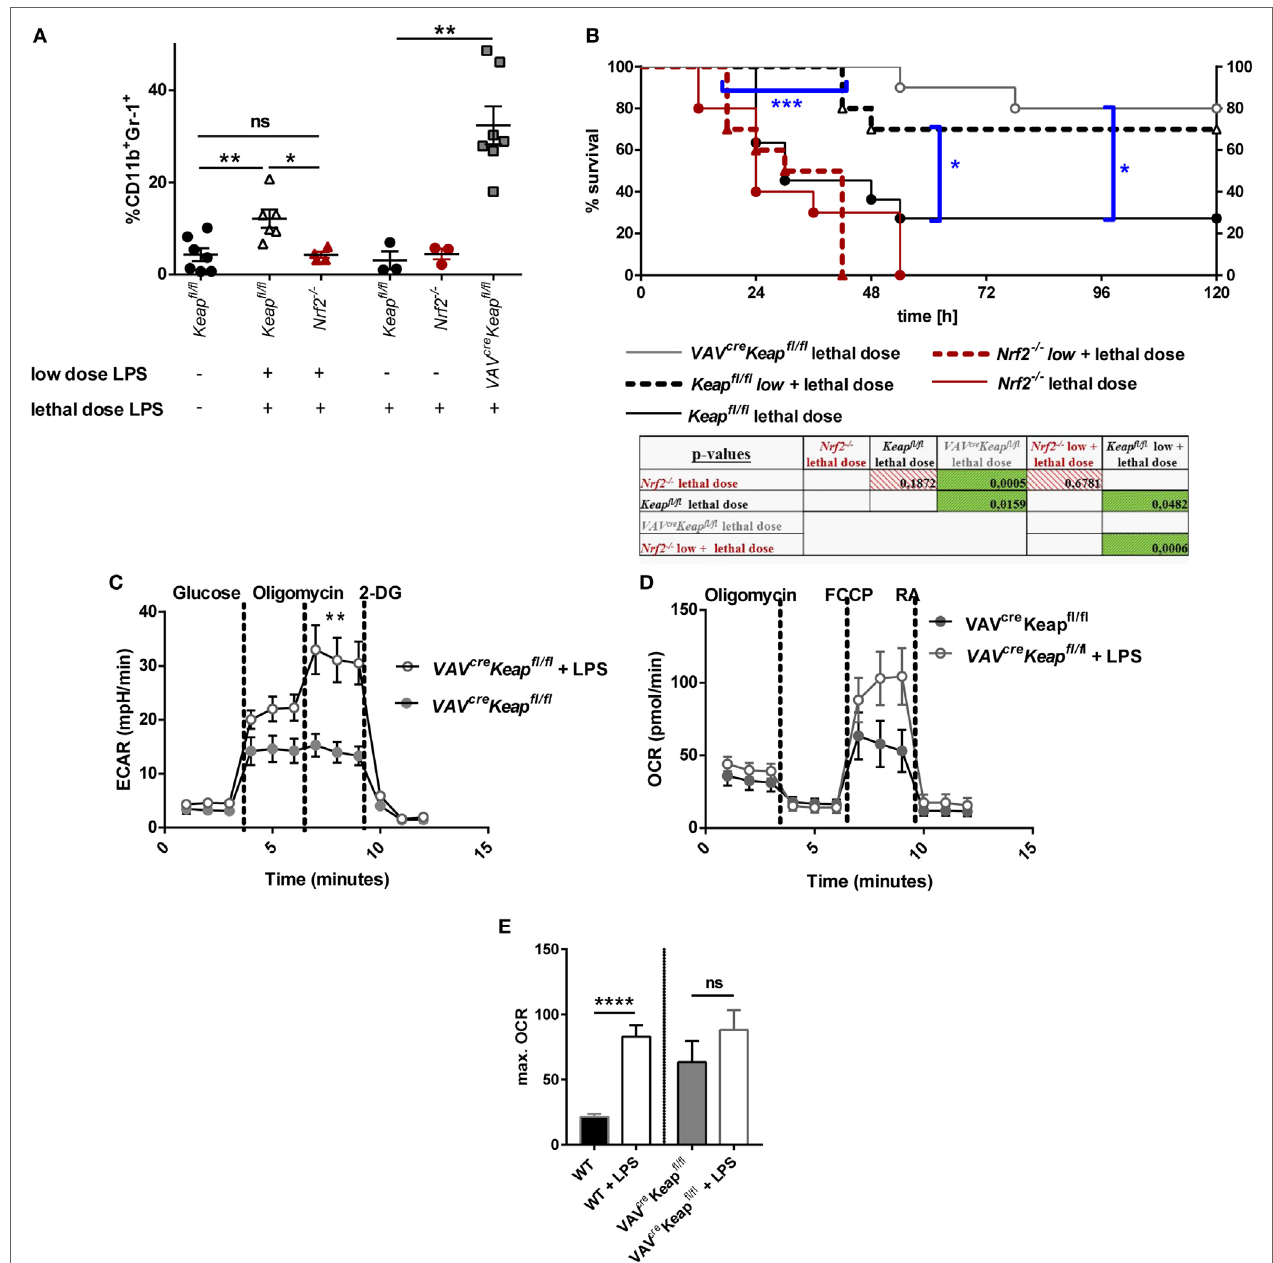
FigUre 7 | Nrf2 activation in myeloid-derived suppressor cells (MDSCs) regulates LPS-mediated disease. (a) Mice were injected with either a low dose of LPS (5 mg/kg of body weight) and subsequently with a lethal dose of LPS (30 mg/kg of body weight) or solely with a lethal dose of LPS (30 mg/kg of body weight). Mice were euthanized depending on a scoring system (usually within the first 48 h after the single lethal dose) or 72 h after injection of the subsequent lethal dose and frequencies of CD11b + Gr-1 + cells were determined, unpaired, two-tailed t -test, ± SEM, N = 10 mice/group. (B) Kaplan–Meyer survival curves of mice, p -values were determined by Log-rank/Mantel-Cox Test of survival curves (single comparisons) and a subsequent FDR correction of single p -value for multiple comparison test. (c) ECAR measured under basal conditions and after addition of the indicated drugs. Points indicate mean from three control and three LPS treated VAV cre Keap fl/fl splenic MDSCs ± SEM. (D) OCR measured under basal conditions and after addition of the indicated drugs. Points indicate CD11b + Gr-1 + cells from three control and three LPS treated mice ± SEM. (e) Statistical analysis of max. OCR. Bars indicate mean ±